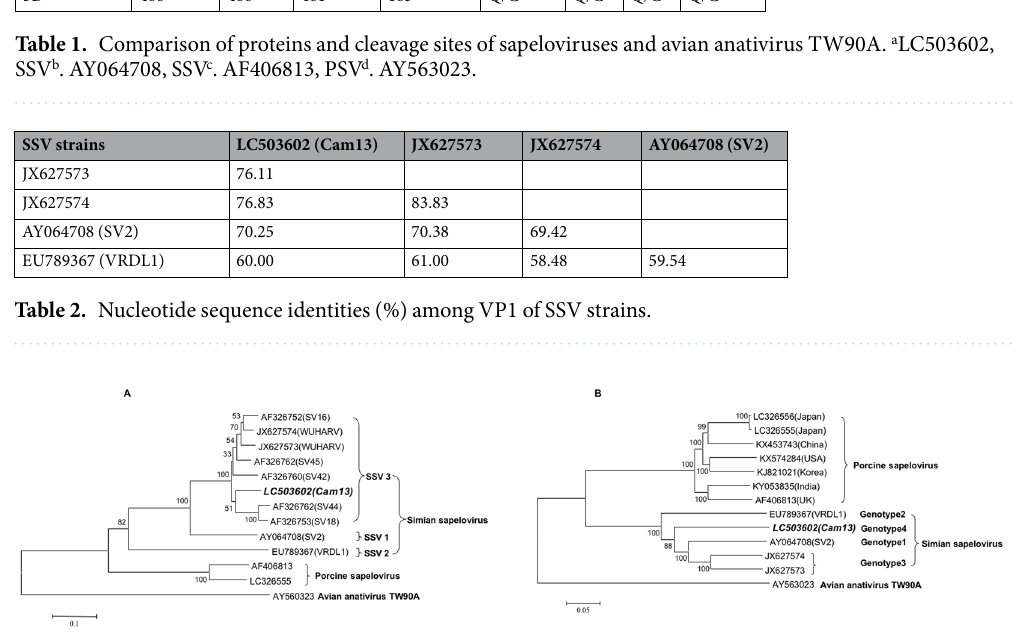
Figure 3. Phylogenetic relationships among SSV strains. The amino acid and nucleotide sequence alignment was performed using ClustalW software, with an Avian anativirus TW90A as the out-group. The genetic distance was calculated by Kimura’s two-parameter method. Phylogenetic trees with 1,000 bootstrap replicates were generated by the Neighbor-Joining method using MEGA (ver. 6) based on the aa sequence of VP1 ( A ) and the entire genome ( B ) of SSV, PSV, and TW90A. Scale bar indicates amino acid or nucleotide substitutions per site. Strain Cam13 strain is shown in bold italic letters. The genotype is tentatively named based on the findings of our present study.